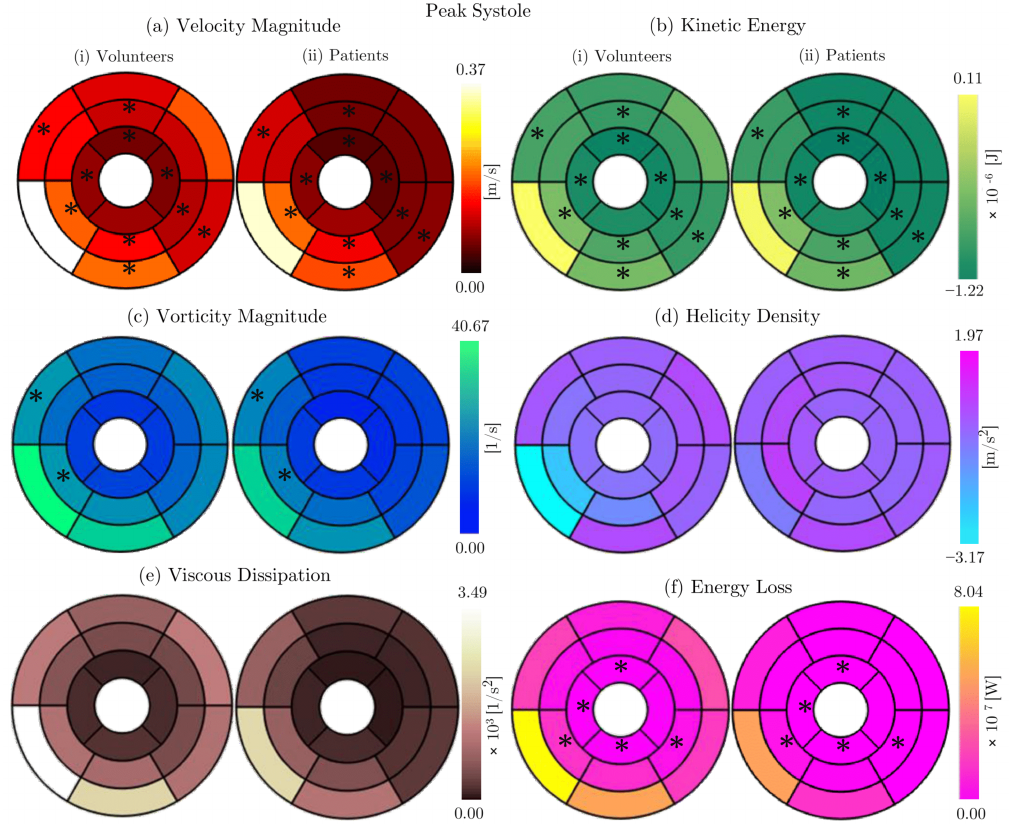
Figure 5. Bullseye plots of mean hemodynamic parameters ( a – f ) across 16 segments for volunteers (i) and patients (ii) at the peak systole. * indicates statistically significant differences ( p <